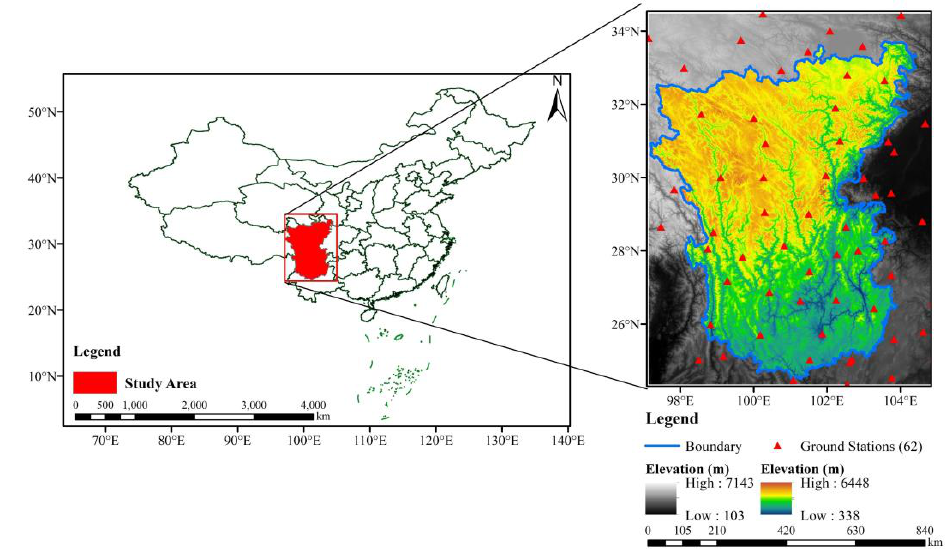
Figure 1. Spatial distribution of ground-based stations in and around the